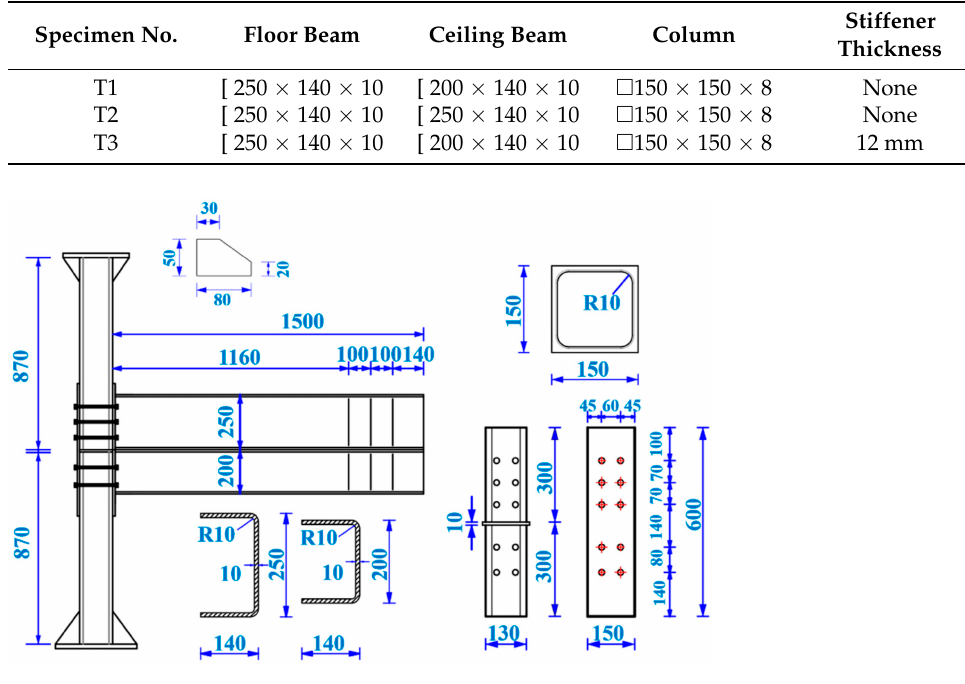
Figure 3. Geometric configuration of tested specimens (units: mm).